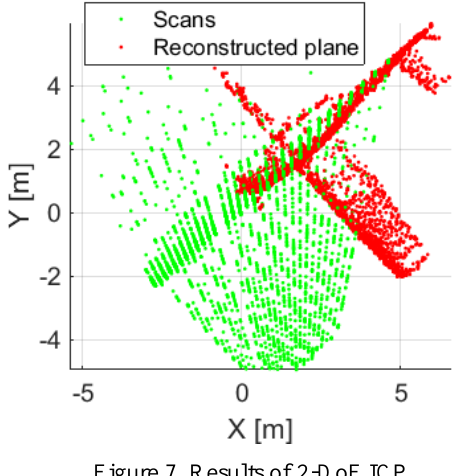
Figure 7. Results of 2-DoF